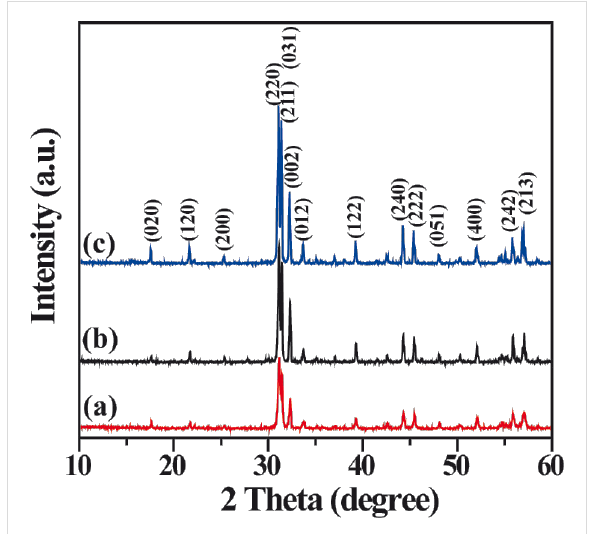
Figure 1: XRD patterns of Ag 2 CrO 4 samples prepared by different methods: (a) microemulsion, (b) precipitation, and (c)